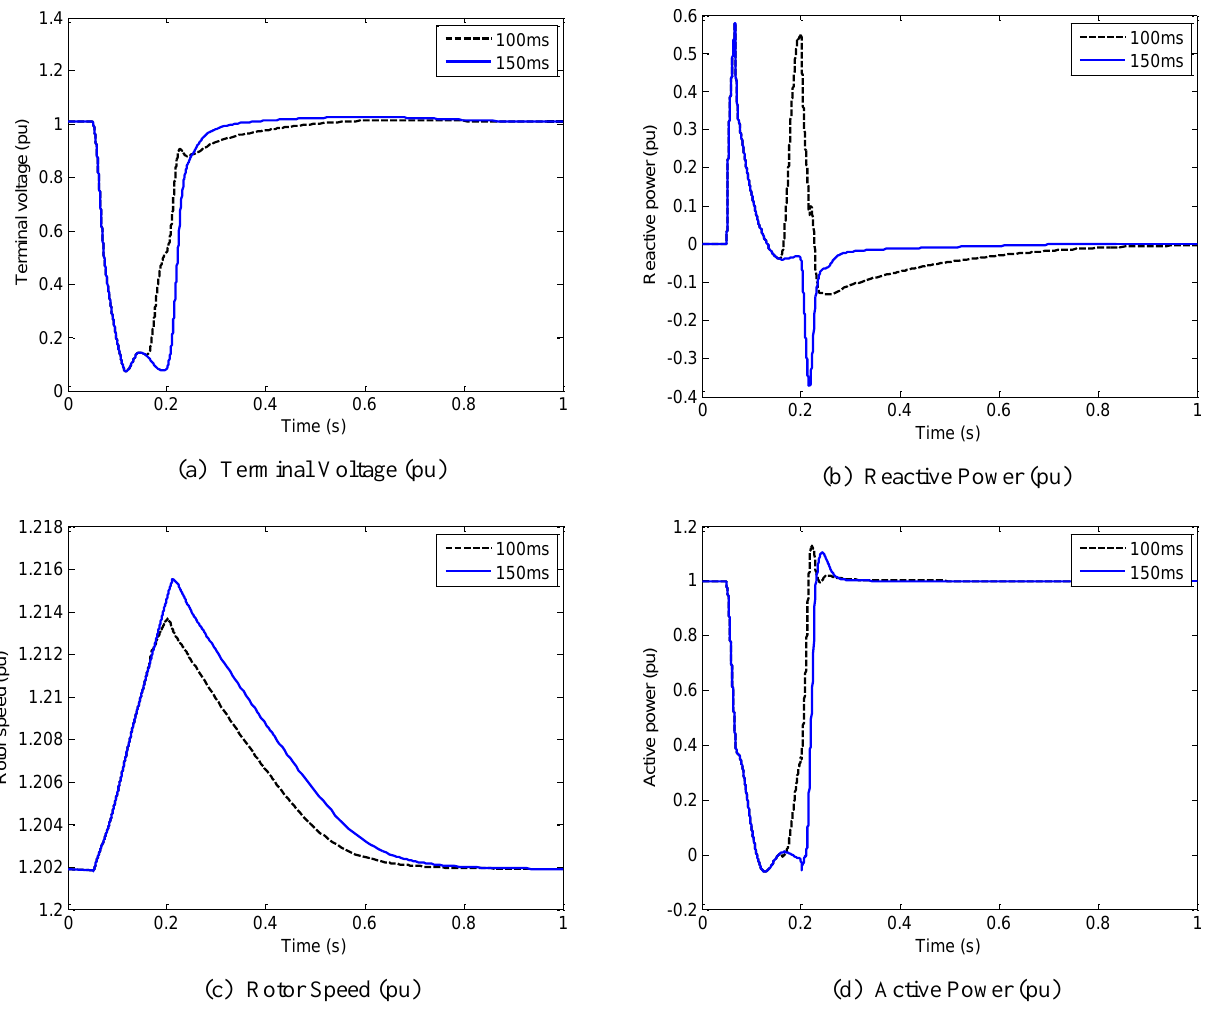
Figure 11. Dynamic analysis of the DFIG for different crowbar operation time during a fault at B5 eliminated in 150